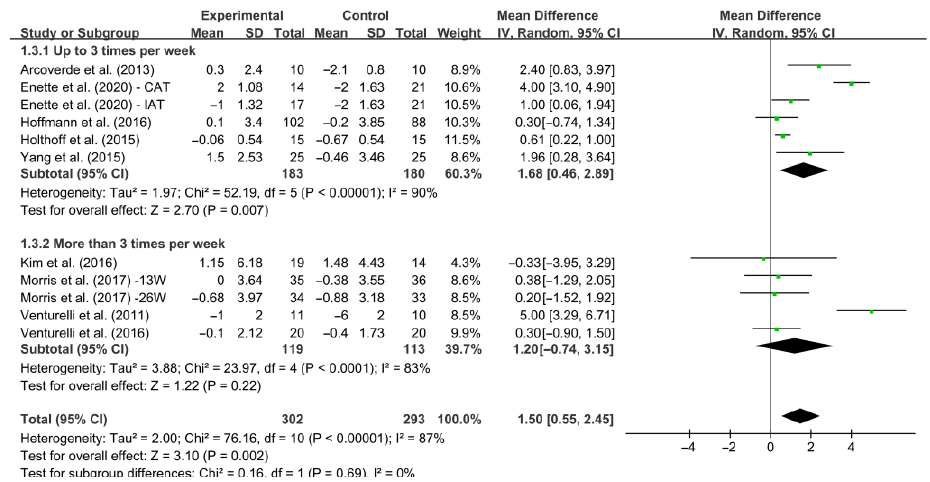
Figure 7. Meta-analysis results of the effect of the frequency of intervention per week on cognitive function in AD patients [20,27,39 – 45].